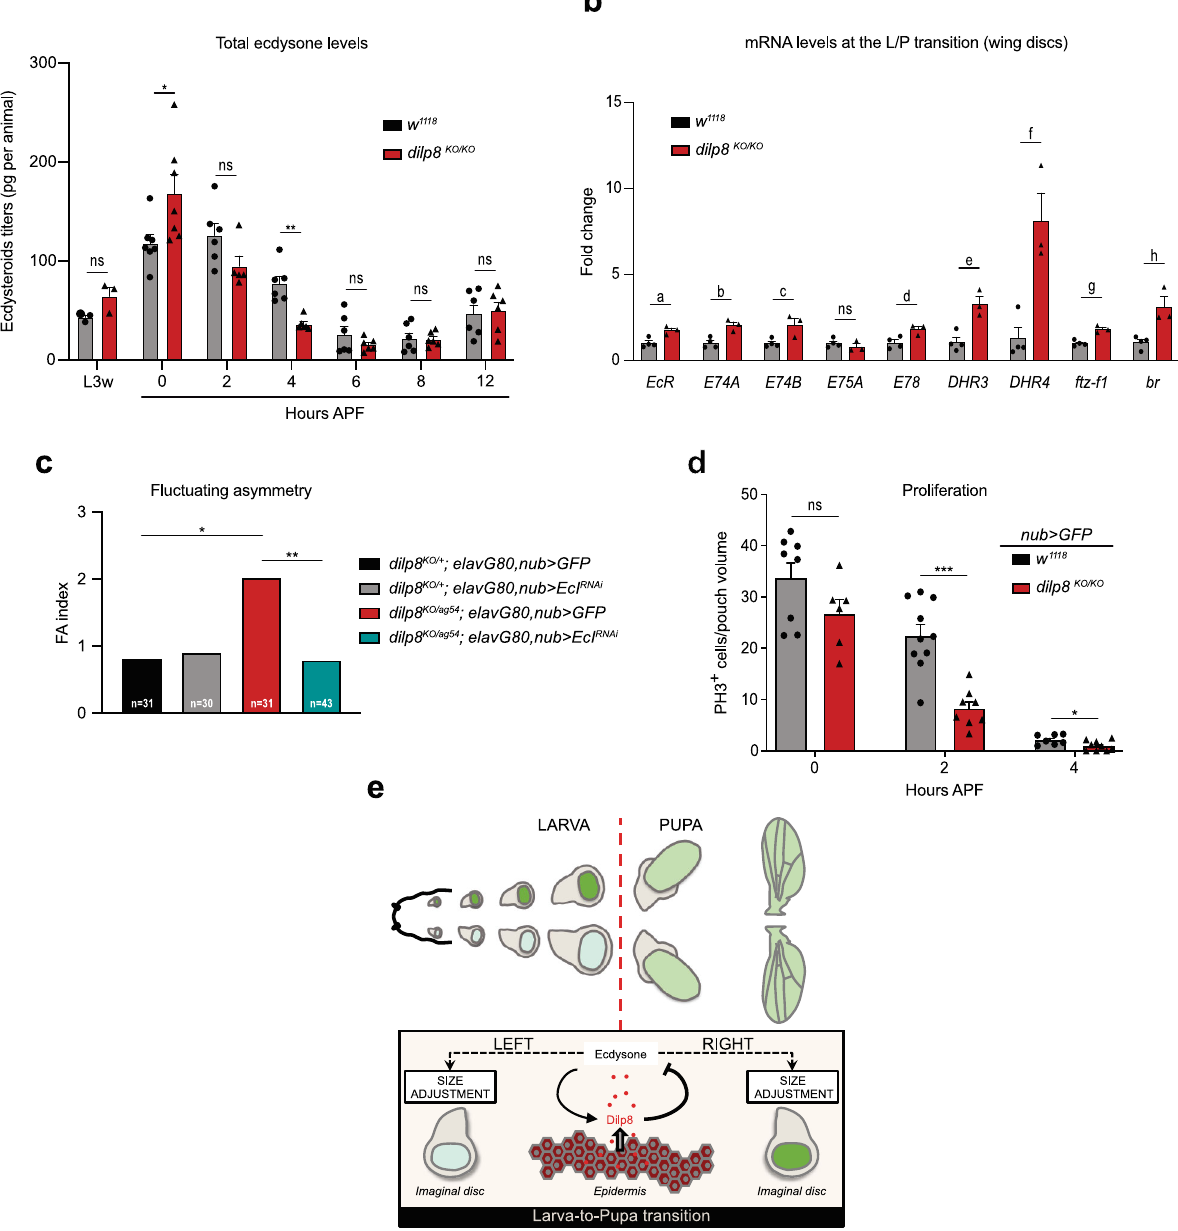
Fig. 5 | Dilp8 is required to adjust ecdysone levels at the L/P transition. a Ecdysteroids titers in whole animals at the indicated time points for controls (in black)and dilp8 KO/KO (inred)mutantanimals.AtL3w, n =3biologicallyindependent samples measured per genotype; at 0h AFP, n =7 per genotype; for other time points, n=6 per genotype except for dilp8 KO/KO 2h APF, where n =5. Error bars represent SEM. ** p =0.0006, * p =0.0338 and ns=not signi fi cant, multiple two- tailed t -tests. b Measurement of ecdysone targets by qRT-PCR on wing imaginal discs at WPP stage in controls (in black) and dilp8 KO/KO (in red) mutant animals. Values are fold changes relative to controls. Error bars represent SEM. a: p value=0.0119, b: p value=0.0076, c: p value=0.0253, d: p value=0.0248, e: p value=0.0058, f: p value=0.0069, g: p value=0.0019, h: p value =0.0114 and ns=not signi fi cant, multiple two-tailed t -tests. n =4 biologically independent samplesanalyzed forcontrols and n =3for dilp8 KO/KO animals. c FAindexes of adult